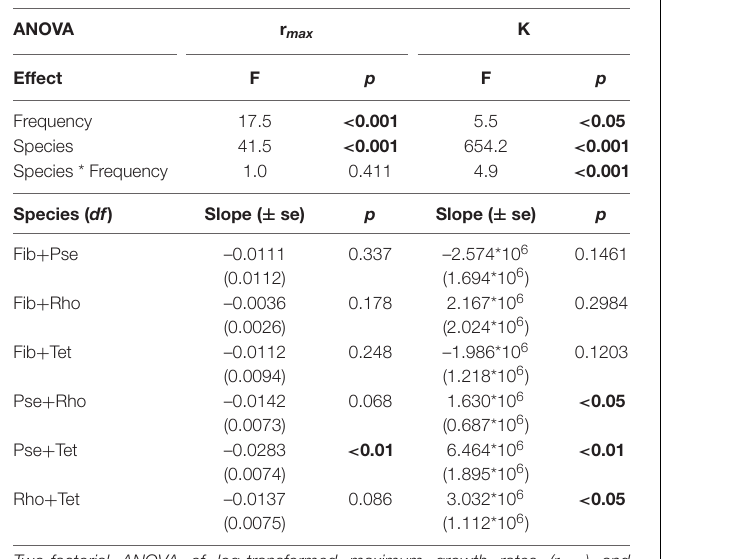
TABLE 4 | Two-species mixtures under fluctuating light.